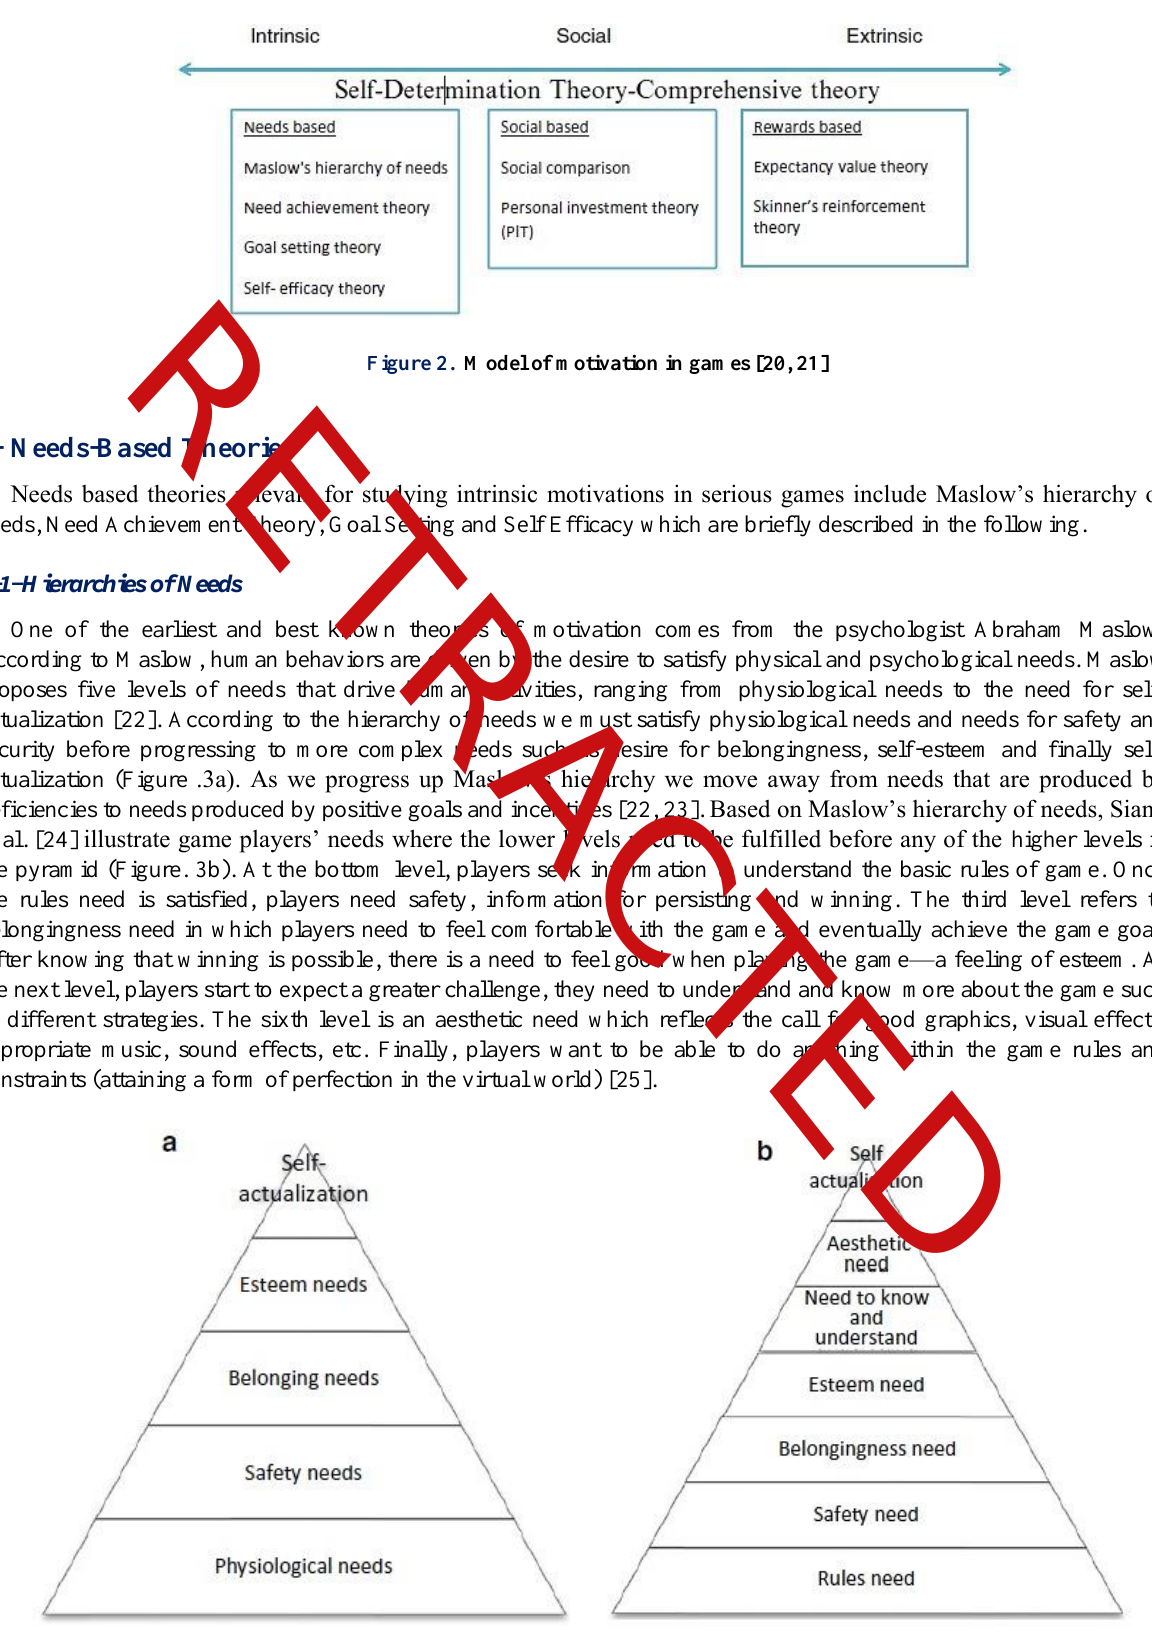
Figure 3. (a) Maslow’s hierarchy of needs, (b) Hierarchy of players’ needs licensed from [23,